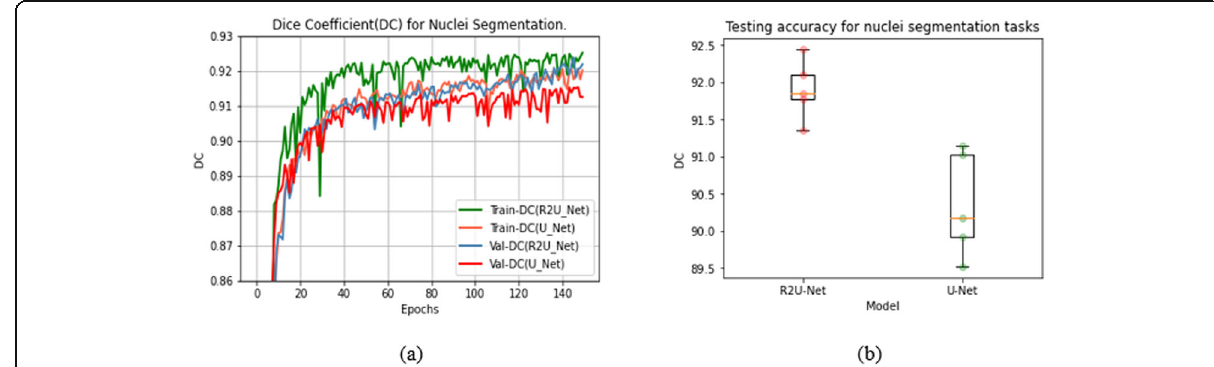
Fig. 12 Results for nuclei segmentation model. a Training and validation DC for the best R2U-Net and U-Net models. b Box plot of testing DC score for five-fold